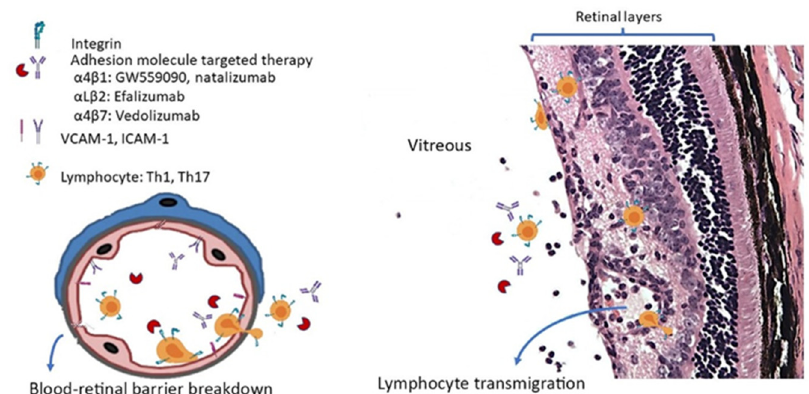
Figure 2. A schematic figure illustrating how adhesion molecules are involved in the process of leukocyte transmigration in uveitis and the current adhesion molecule targeted therapy being used in experimental autoimmune uveitis and non-infectious